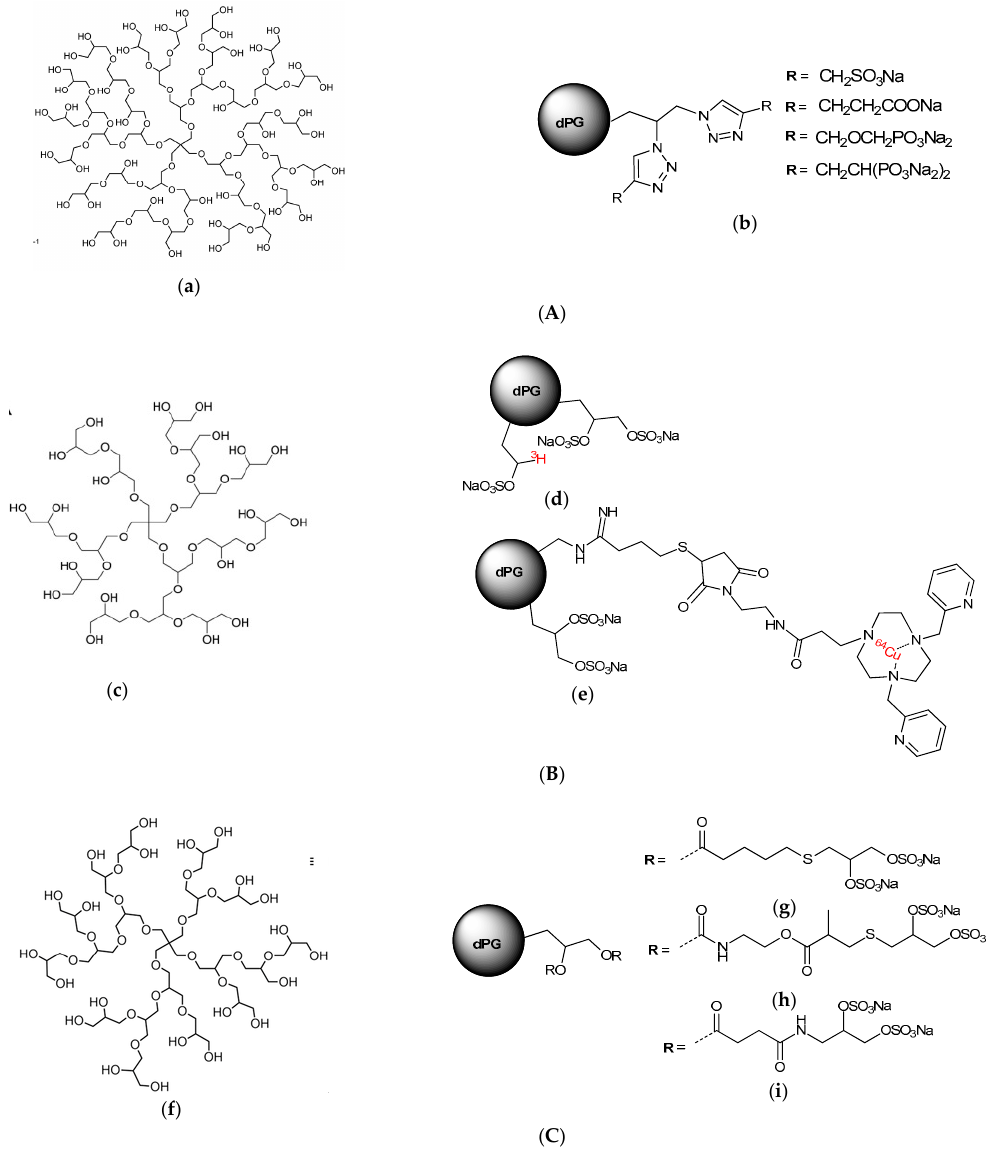
Figure 11. Structure of dendritic polyglycerol heparin mimetics: The structure of dendritic polyglycerols (dPG) scaffold illustrates an idealized fragment of the polymer. ( A ) Structure of ( a ) dendritic polyglycerol starting material and ( b ) dendritic polyglycerol heparin mimetics synthesized via click coupling by Weinhart et al. [117]; ( B ) Structure of ( c ) dendritic polyglycerol starting material and ( d , e ) radiolabeled dendritic polyglycerol heparin mimetics synthesized by Pant et al. [118]; ( C ) Structure of ( f ) dendritic polyglycerol starting material and ( g – i ) shell cleavable dendritic polyglycerol heparin mimetics synthesized by Reimann et al. [95].